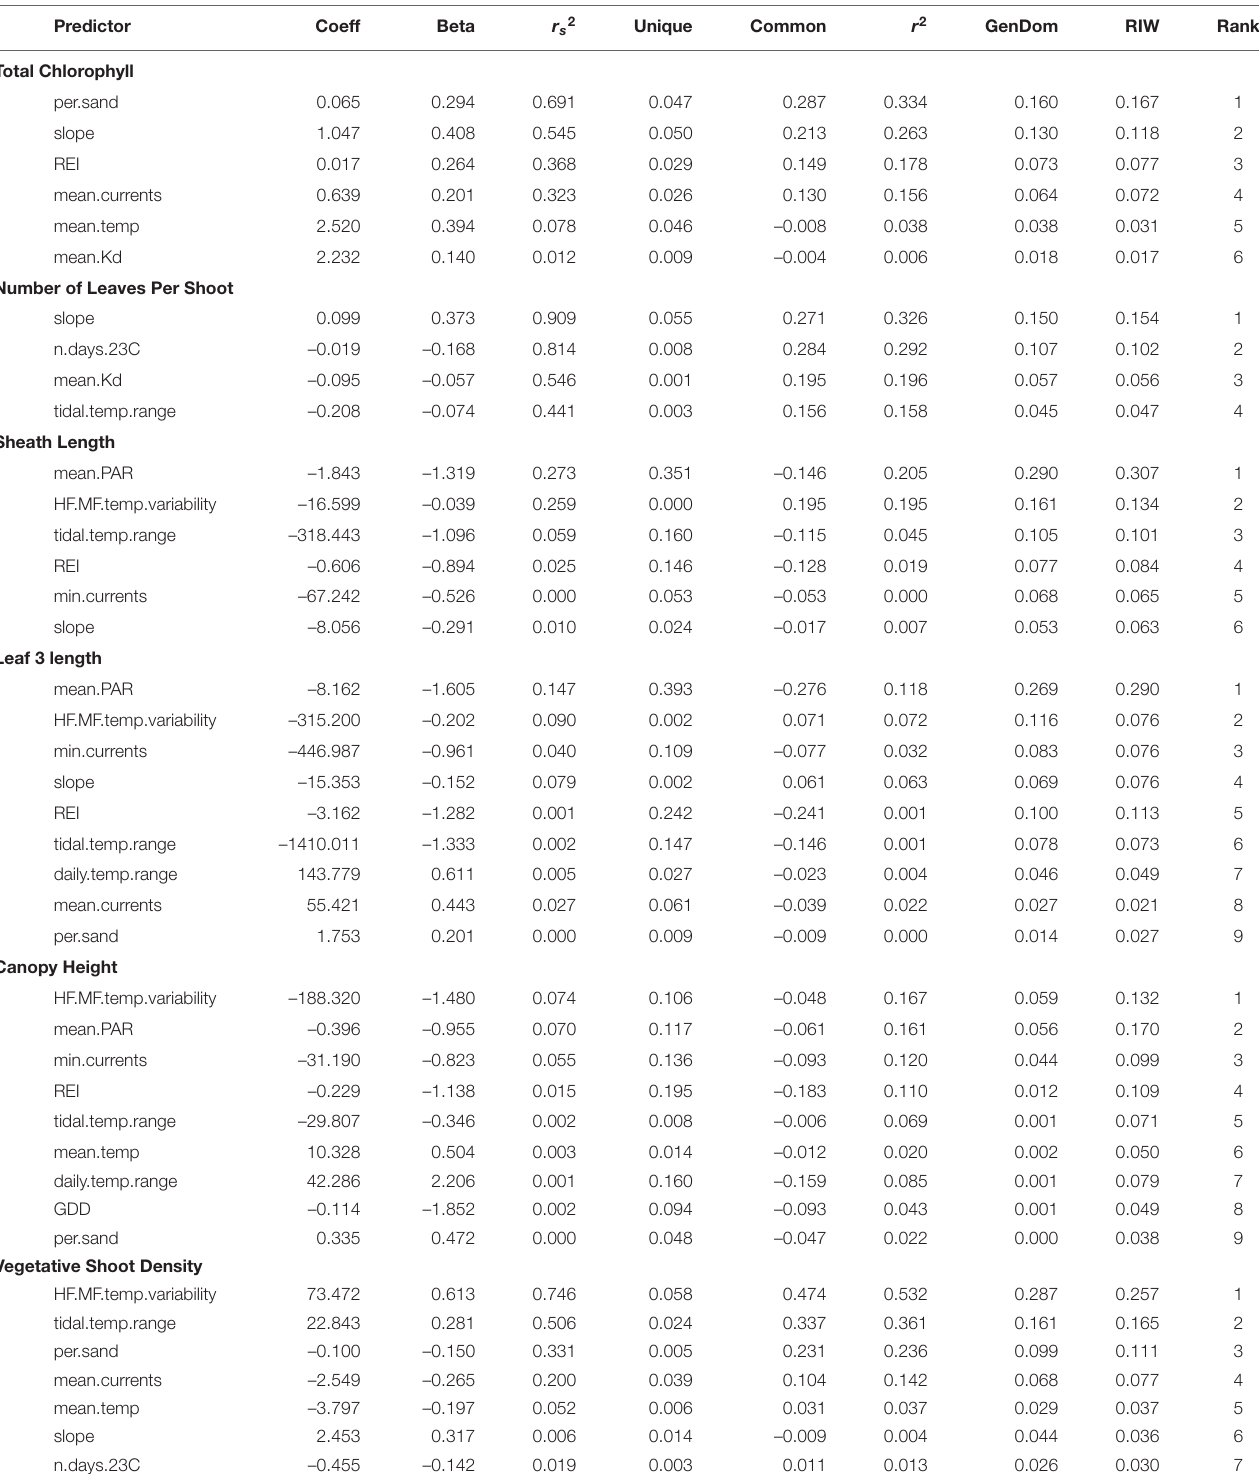
TABLE 2 | Regression results for biological metrics of production.